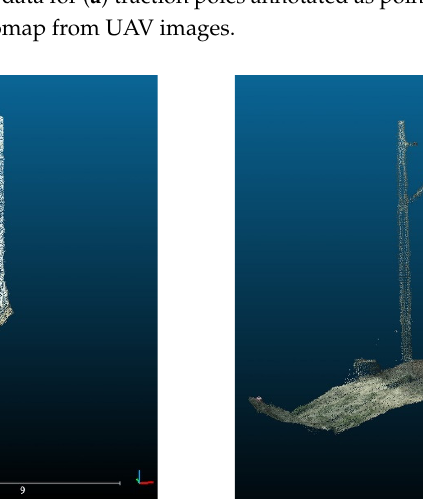
Figure 3. Examples of annotation data for ( a ) traction poles annotated as points and ( b ) gates la- belled as polygons based on orthophotomap from UAV images.